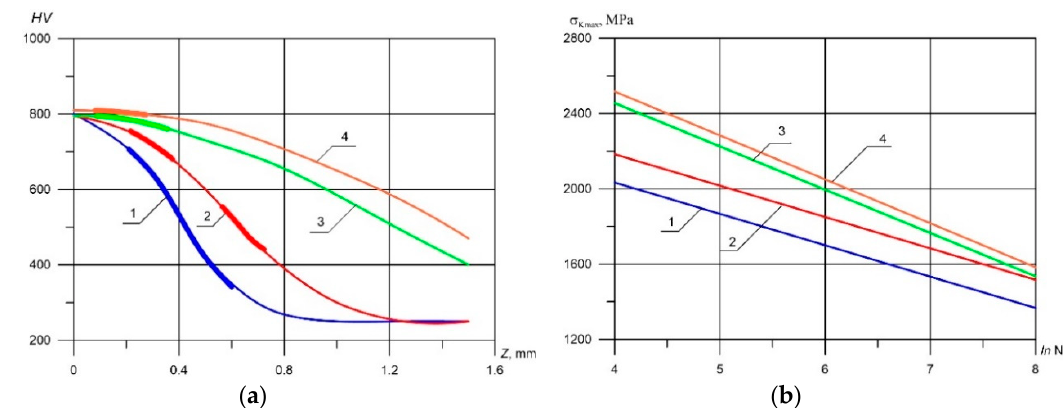
Figure 4. The contact fatigue life of S-120 samples: ( a ) the distribution of hardness over the thickness of the hardened layer and the actual areas of failure (highlighted); ( b ) the Wöhler lines; (1) CA-120; (2) CB-120; (3) CC-120; (4) CD-120.